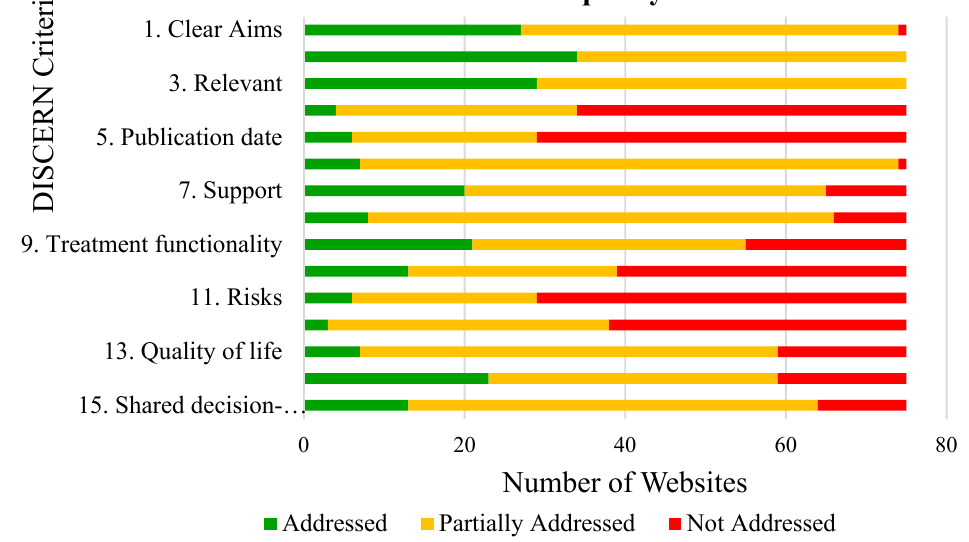
Figure 1. The number of websites out of the total 75 websites that addressed, partially addressed, and did not address each of the 15 DISCERN criteria. The DISCERN criteria include: (1) Are the aims of the website clear and is the target population of the website clear; (2) Does the website achieve the intended aims; (3) Is the website relevant to the needs of the user (in this case, firefighters with post-traumatic stress disorder (PTSD)); (4) Are the sources of information used for the